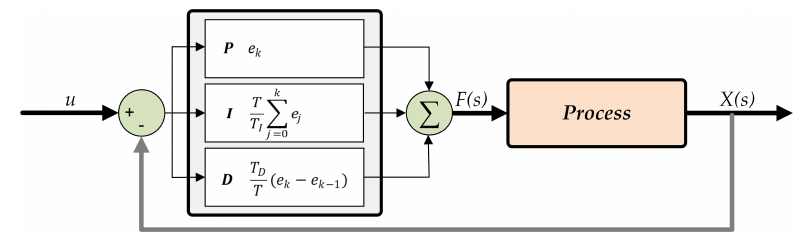
Figure 1. PID control flow